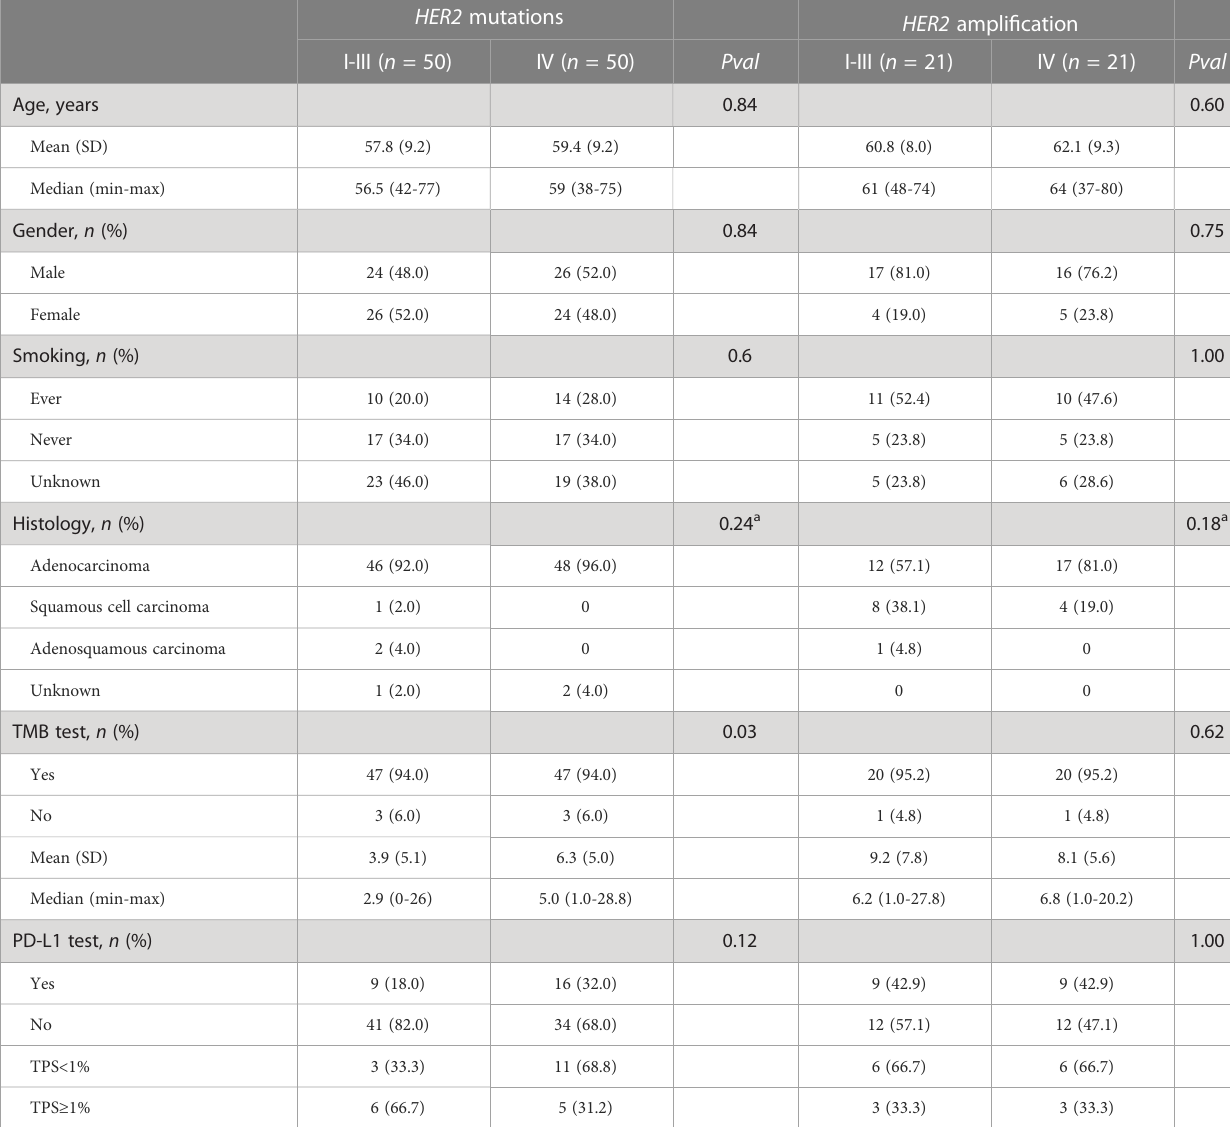
a Comparison between adenocarcinoma and